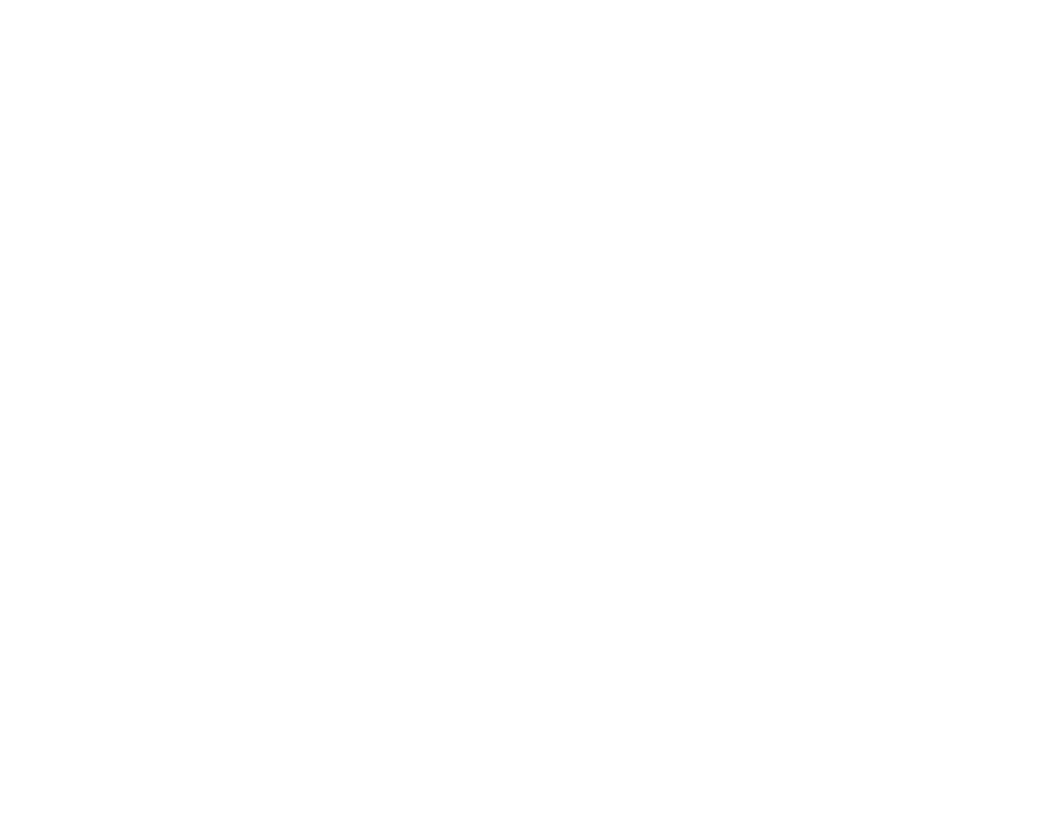
Figure 8. Kaplan–Meier curve and log-rank test for sex differentiation pathway SNP predictive of PFS in KRAS mutant mCRC patients. Patients with DMRT1 rs755383 Any T carriers have longer PFS (9.4 vs. 9.0 mo; p = 0.037) compared to C/C